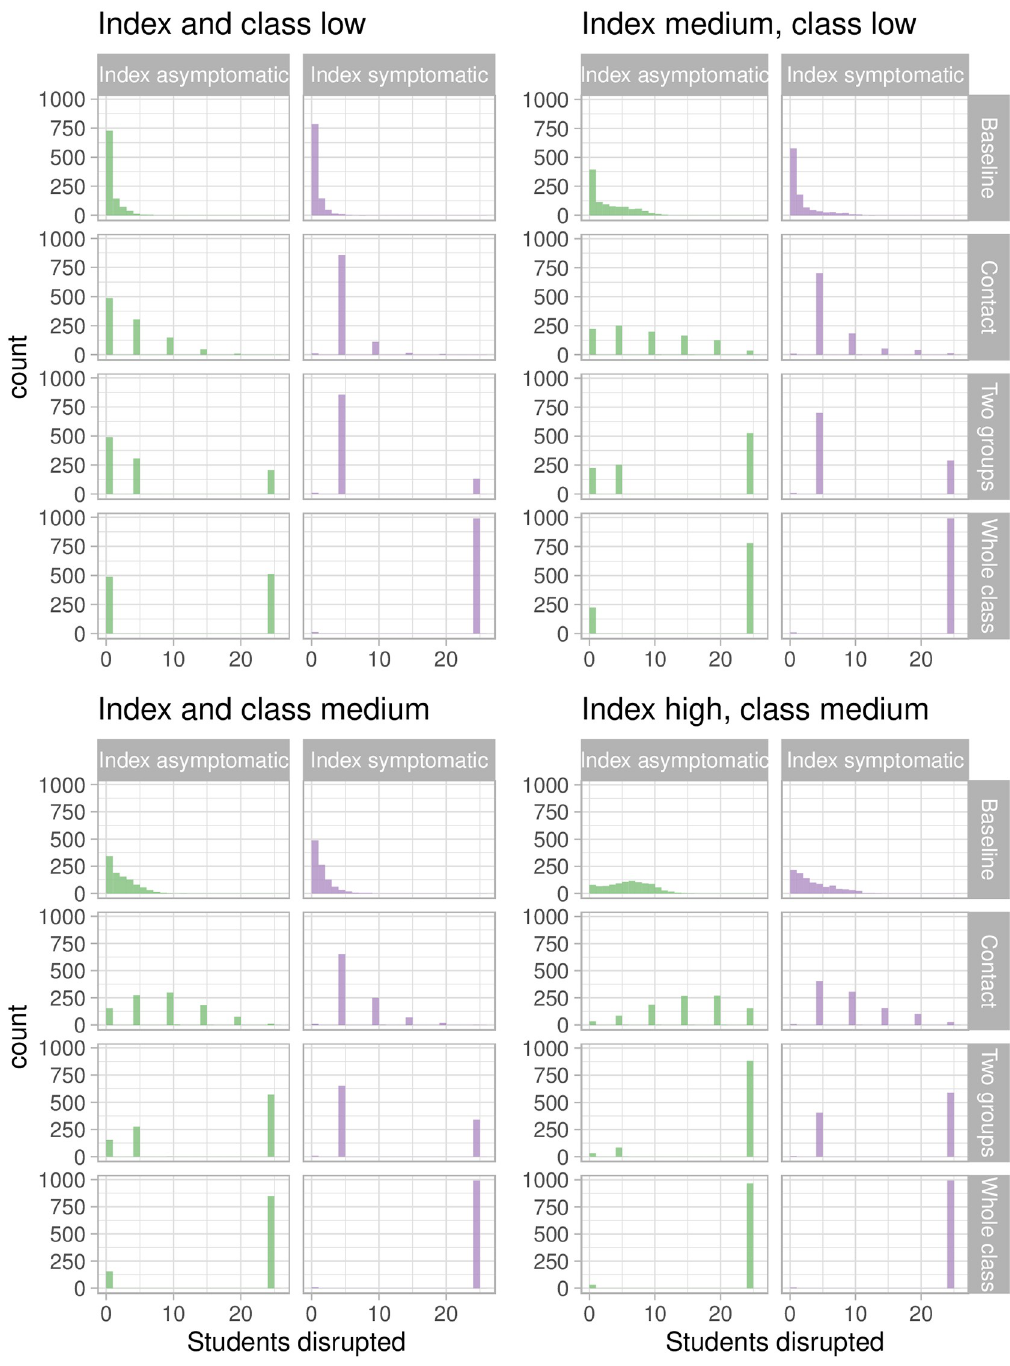
Fig 4. Total disrupted: The total numbers of students who are either asked to isolate or must be tested, in the different protocols, according to the index and classroom’s transmission risk and whether the index case is asymptomatic. A student is included if they became symptomatic and had to isolate, if they were a member of a group that was asked to isolate or when their class was asked to isolate (or be tested).